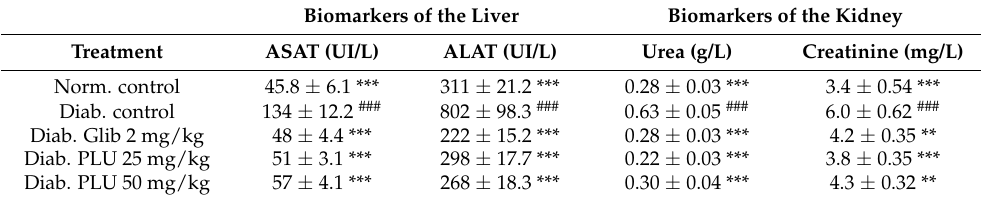
Table 3. Effects of PLU on urea, creatinine, ASAT, and ALAT levels in alloxan-induced diabetic mice. Biomarkers of the Liver Biomarkers of the Kidney